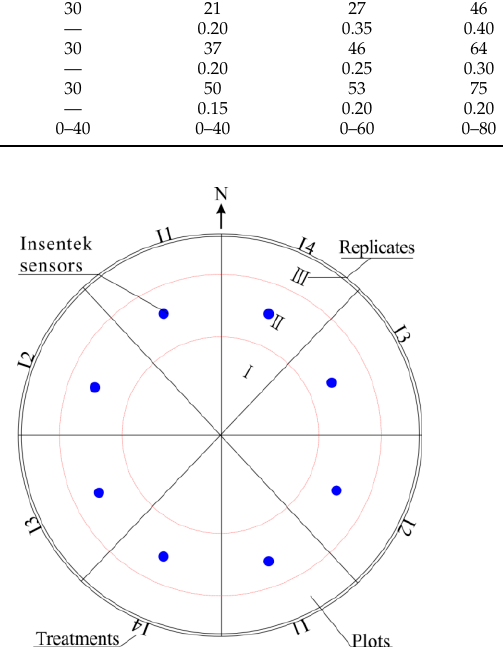
Figure 4. Plot layout of field experiment with the center pivot irrigation system (CPIS). Table 1. Irrigation quota (mm) of different treatments for wheat and maize in the 2019–2020 growing season. Treatments